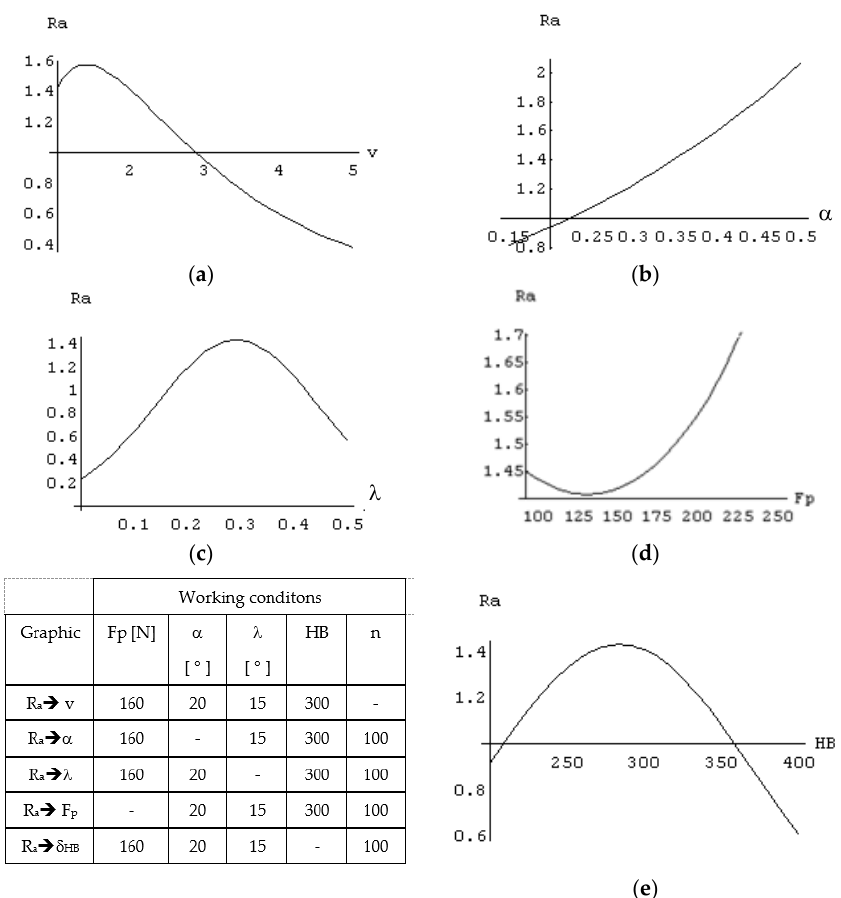
Figure 14. Influence of the optimization factors on objective function “ roughness R a ” : ( a ) speed influence on roughness ( μm ); ( b ) afla influence on roughness ( μm ); ( c ) lambda influence on roughness ( μm ); ( d ) Fp influence on roughness ( μm ); and ( e ) hardness influence on roughness ( μm ).